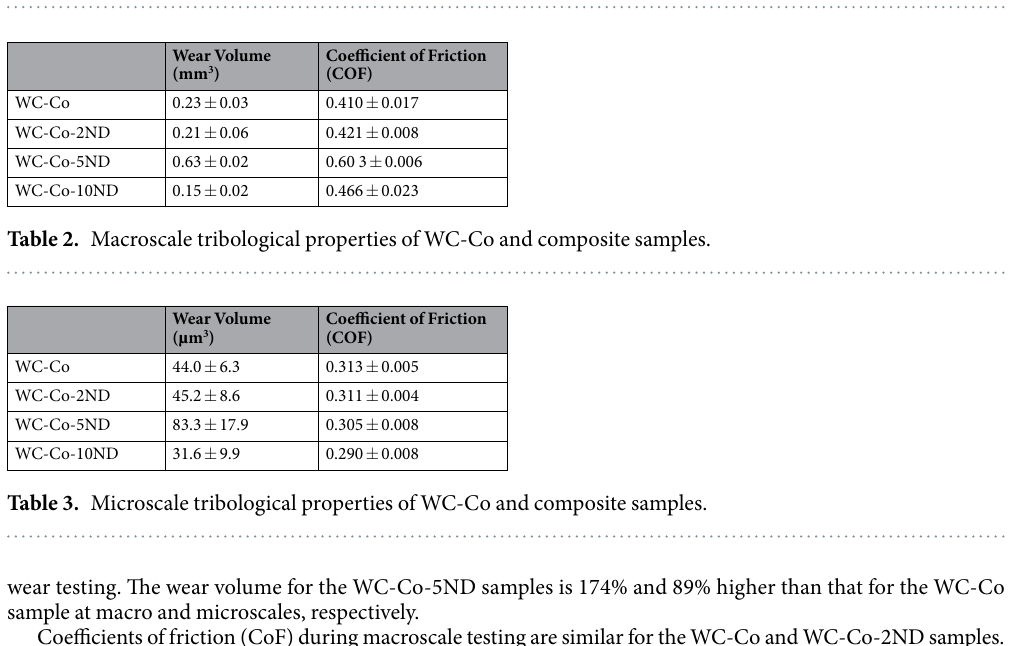
Figure 3. Bright field TEM of WC-Co-10ND sample, ND rich areas with adequate dispersion can be seen within the Co binder, inset: Dark field TEM image of ND rich region showing individual ~10 nm ND particles concentrated in Co binder, near a WC particle.